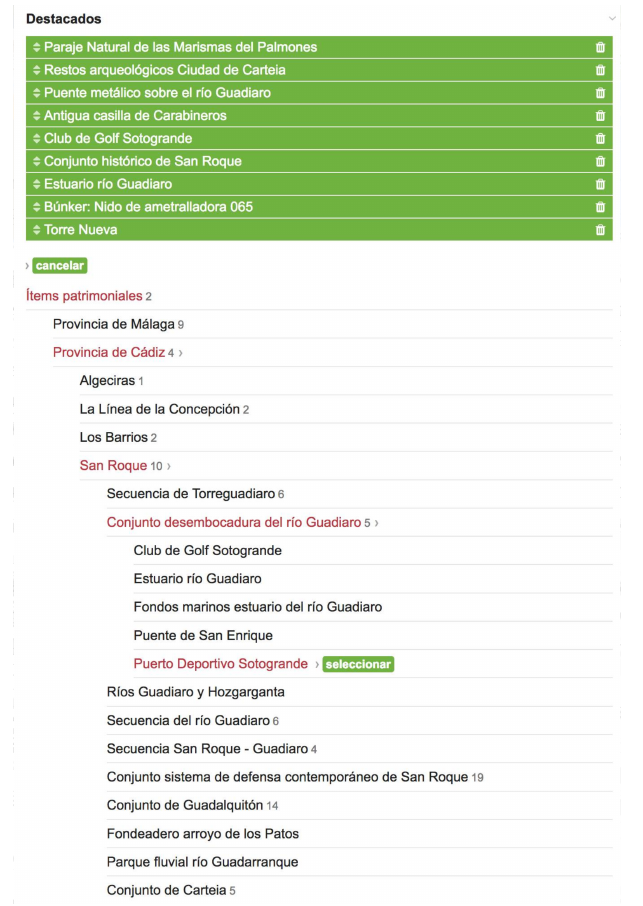
Figure 9. Designing an itinerary. Building an itinerary is a simple matter of selecting pages from the tree. This screenshot of the back end shows how a researcher would add an item called “Puerto Deportivo Sotogrande” to the highlights of the first itinerary. An item can be removed by clicking on the trash icon, and reordered by dragging and dropping to the desired position. Screenshot by the N-340 research team, January